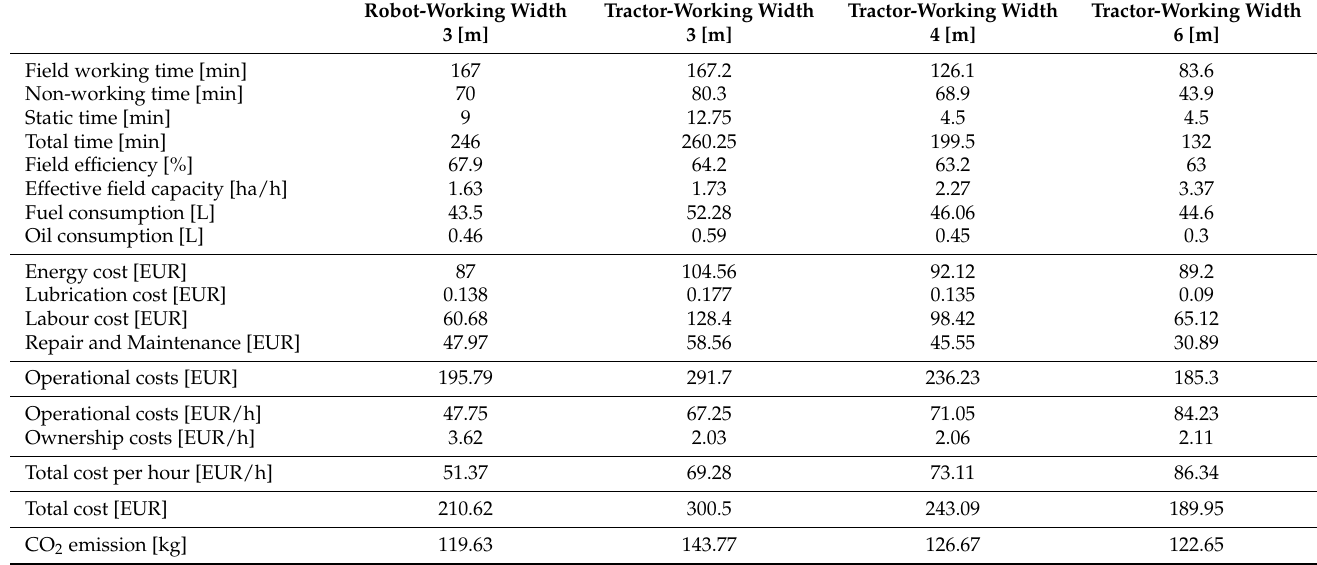
Table 9. The results of in-field operation for the second scenario for the robot and the tractor with different working widths.